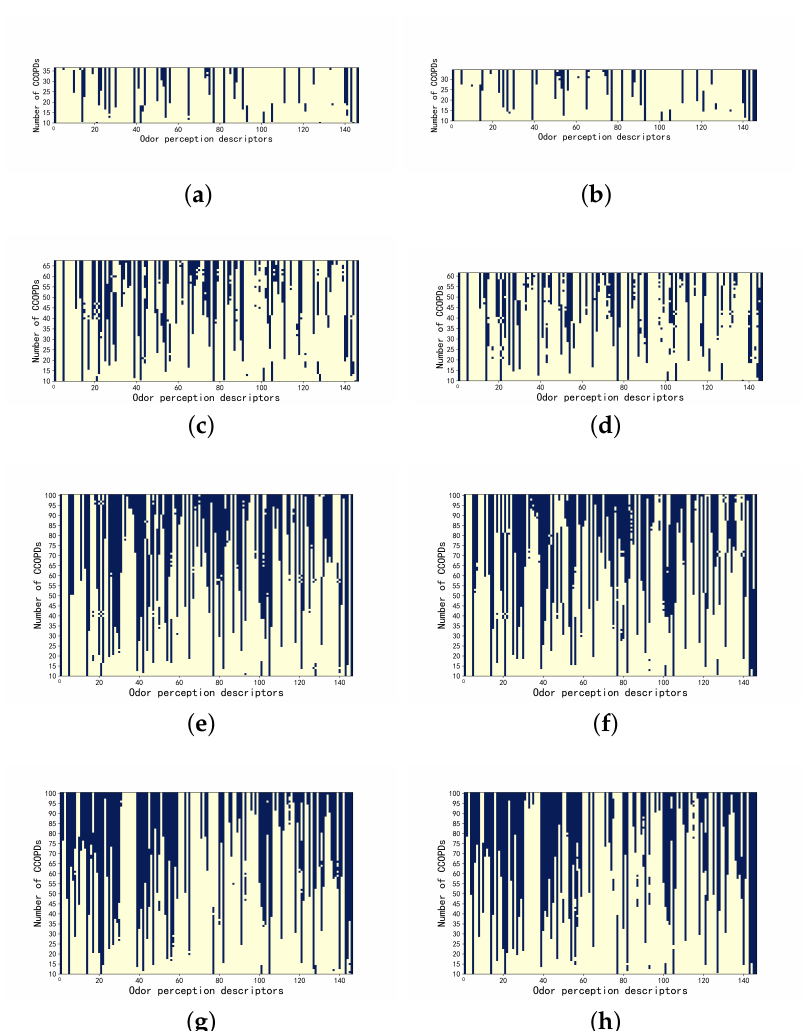
Figure 7. The CCOPDs identified by K-means-disjunctive models and GMM-disjunctive models with different CTs. ( a , c , e , g ) are the results of the CCOPDs identified by GMM-disjunctive models with the CTs of 0.5, 0.65, 0.8, and 1.0, respectively. ( b , d , f , h ) are the results of the CCOPDs identified by K- means-disjunctive models with the CTs of 0.5, 0.65, 0.8, and 1.0, respectively. The black blocks are the CCOPDs, and the yellow block the NCCOPDs. ( a ) The CCOPDs obtained from the GMM-disjunctive model with a CT of 0.50, ( b ) The CCOPDs obtained from the K-means-disjunctive model with a CT of 0.50, ( c ) The CCOPDs obtained from the GMM-disjunctive model with a CT of 0.65, ( d ) The CCOPDs obtained from the K-means-disjunctive model with a CT of 0.65, ( e ) The CCOPDs obtained from the GMM-disjunctive model with a CT of 0.80, ( f ) The CCOPDs obtained from the K-means-disjunctive model with a CT of 0.80, ( g ) The CCOPDs obtained from the K-means-disjunctive model with a CT of 1.0. The CCOPDs obtained from the GMM-disjunctive model with a CT of